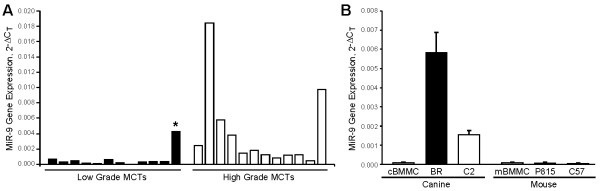
MiR-9 is highly expressed in biologically high grade canine MCTs and malignant mast cell lines. (A) Real-time PCR evaluating mature miR-9 expression in primary canine MCTs demonstrated that the mean expression of miR-9 was 3.2-fold higher in aggressive, high grade MCTs compared to benign MCTs (p = 0.001). (*) indicates primary tumor sample from a dog with a low-grade mast cell tumor that expressed high levels of miR-9 but had lymph node metastasis at the time of surgery. (B) Malignant canine BR and C2 mast cells, normal canine and mouse BMMCs, and malignant mouse C57 and P815 cells were cultured and real-time PCR was performed to assess miR-9 expression levels. Three independent experiments were performed and all reactions were performed in triplicate. The experiments were repeated 3 times in the cell lines and twice for normal cBMMCs.